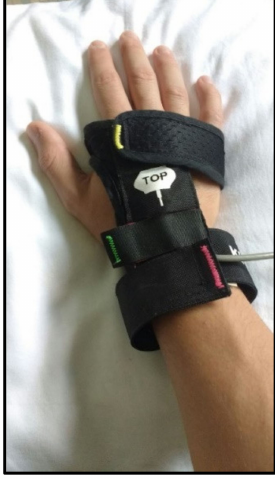
Figure 2. Sensorized electromagnetic